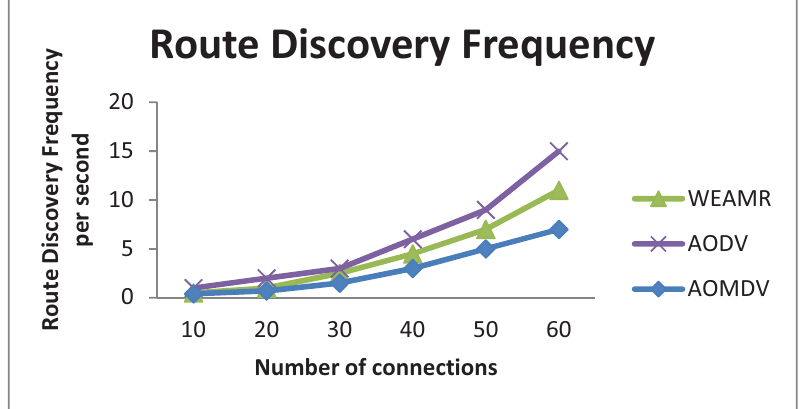
Figure 12. Average Route Discovery frequency with increasing number of connections.